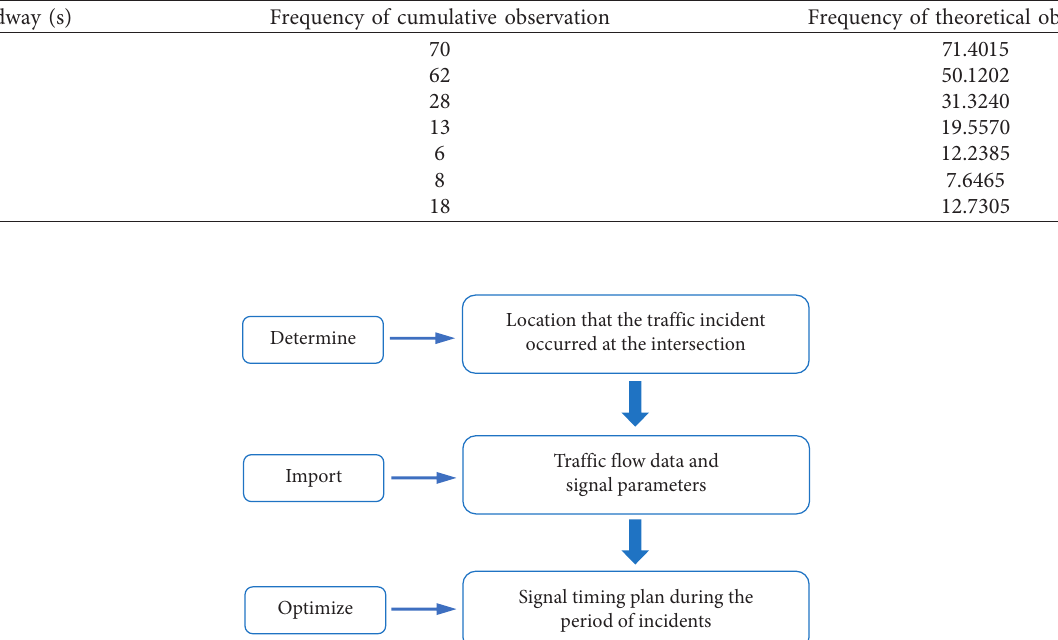
Table 1: Vehicles leaving the departure road.